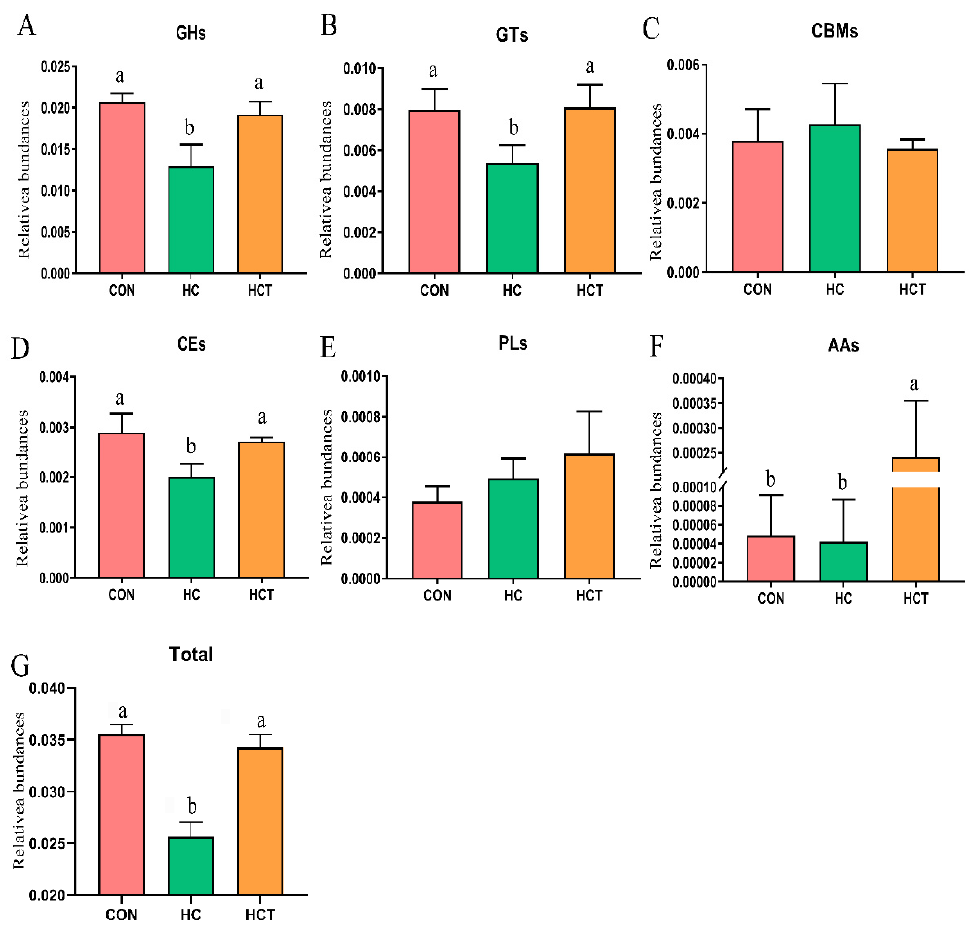
Figure 3. Effects of high-concentrate diet and thiamine supplementation treatment on the relative abundances of carbohydrate-active enzymes. (a − b) Means with different letters differed significantly ( p < 0.05). CON: Control diet; HC: High-concentrate diet; HCT: High-concentrate diet supplemented with thiamine. GH: Glycoside hydrolases; GT: Glycosyl transferases; CBM: Carbohydrate-binding module; CE: Carbohydrate esterases; PL: Polysaccharide lyases; AA: Auxiliary activity; Total: Sum of relative abundance of GH, GT, CBM, CE, PL, and AA.